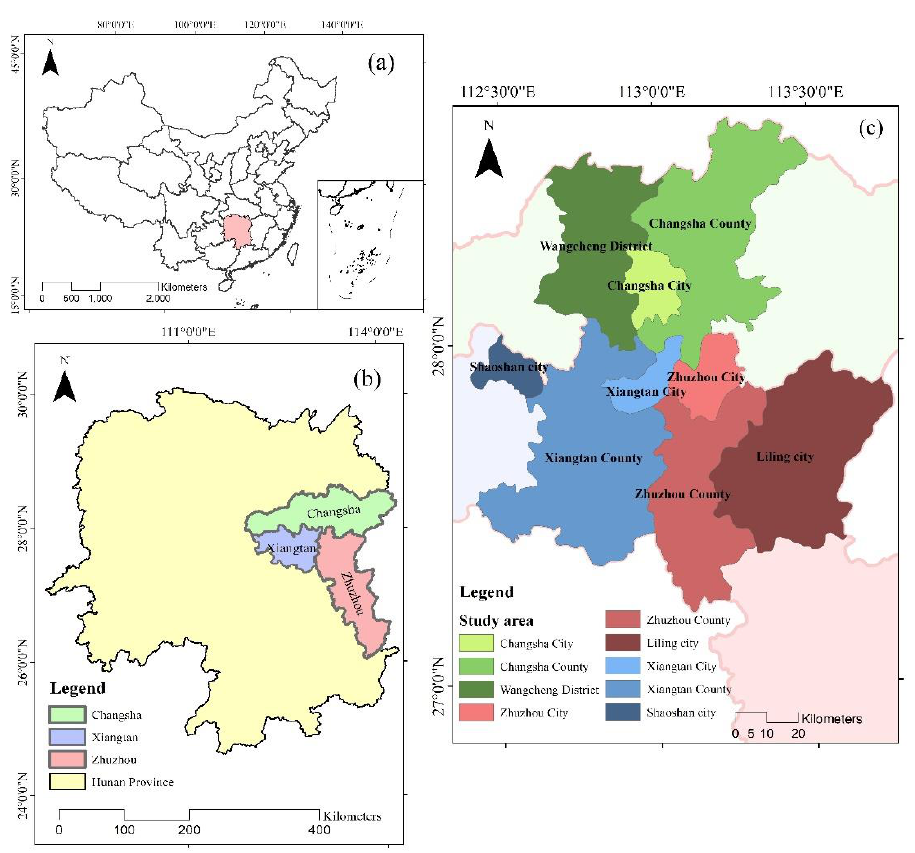
Figure 1. The location of the study area: ( a ) the study area in China; ( b ) the study area in the Hunan Province; ( c ) the distribution of the nine regions in Chang–Zhu–Tan.